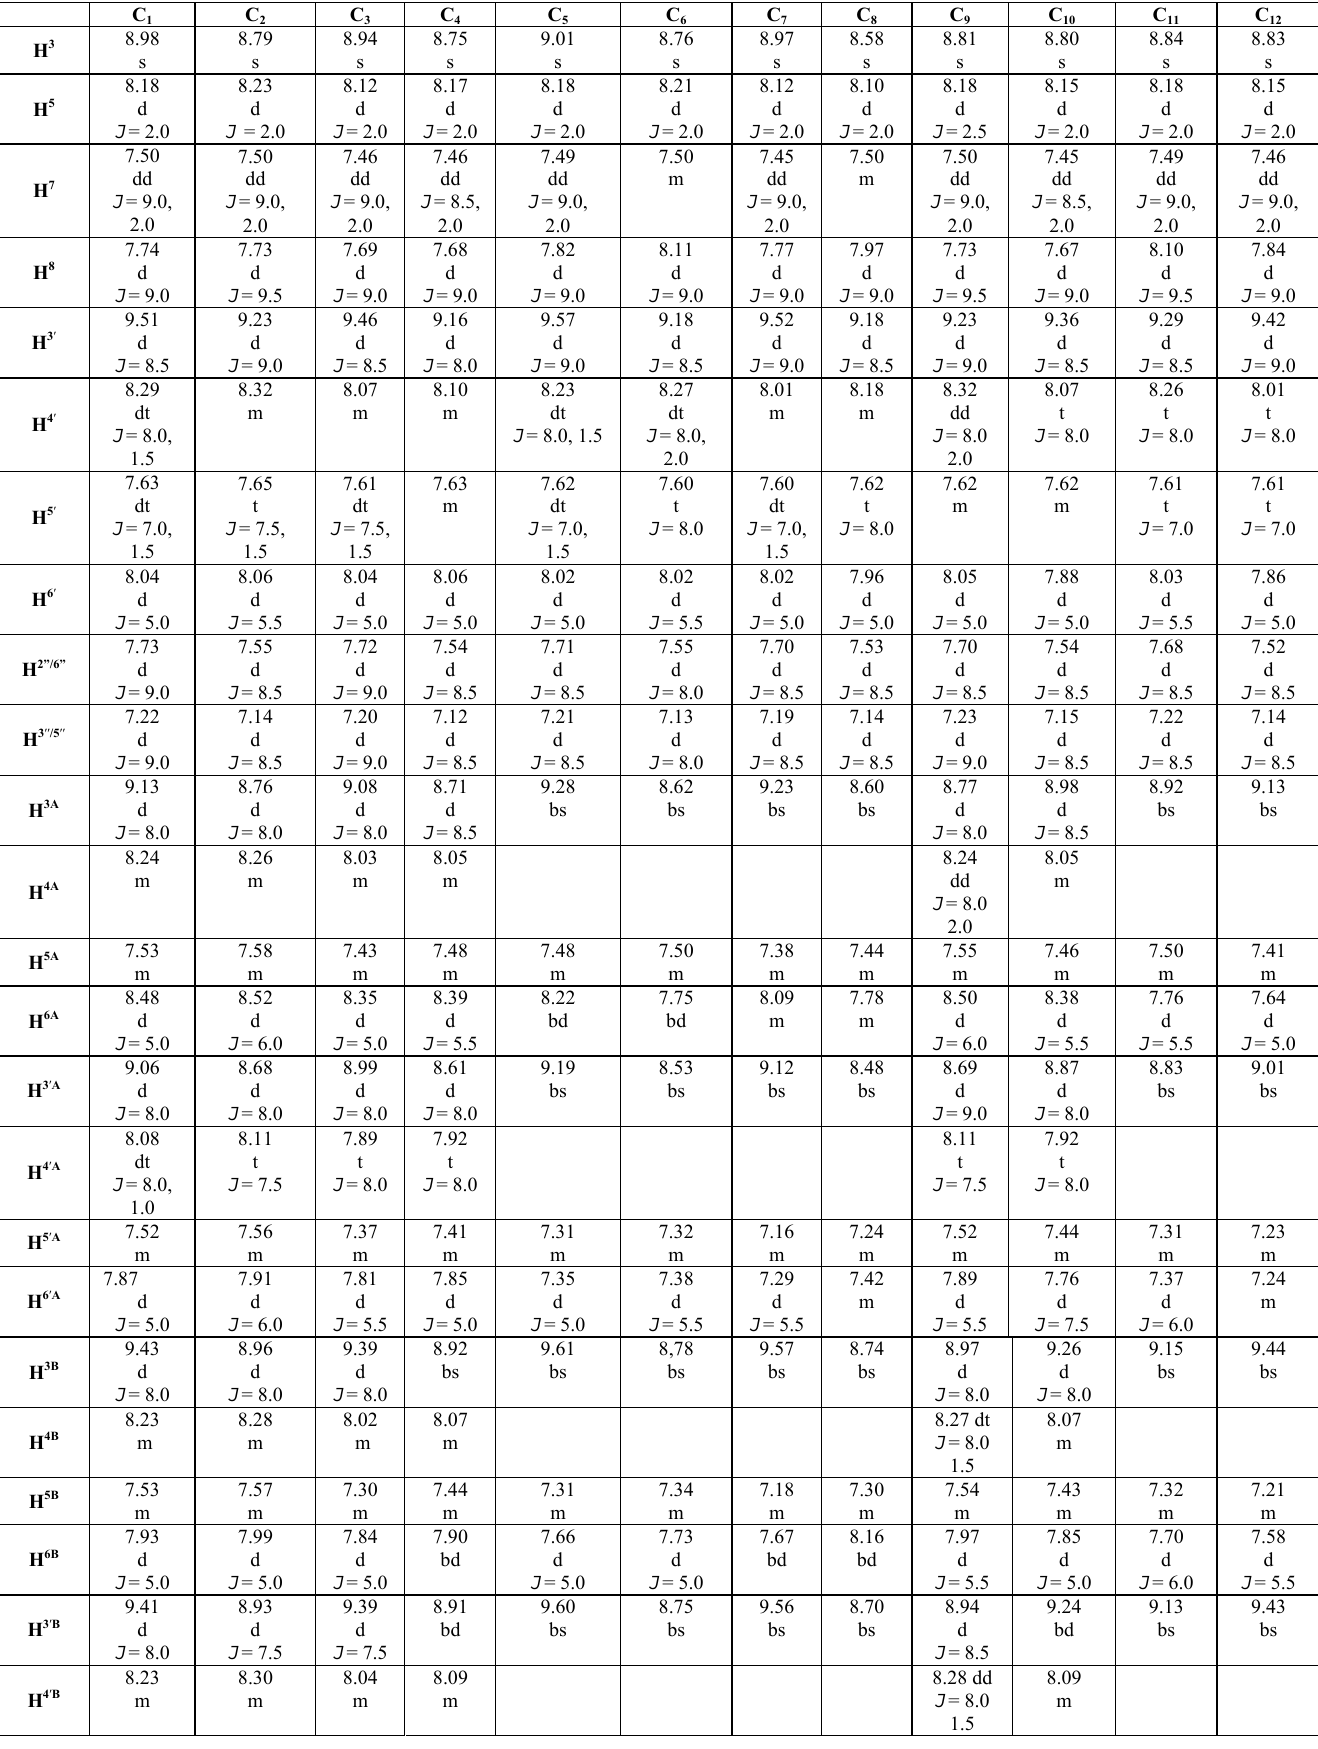
– C . Coupling constants in 1 12